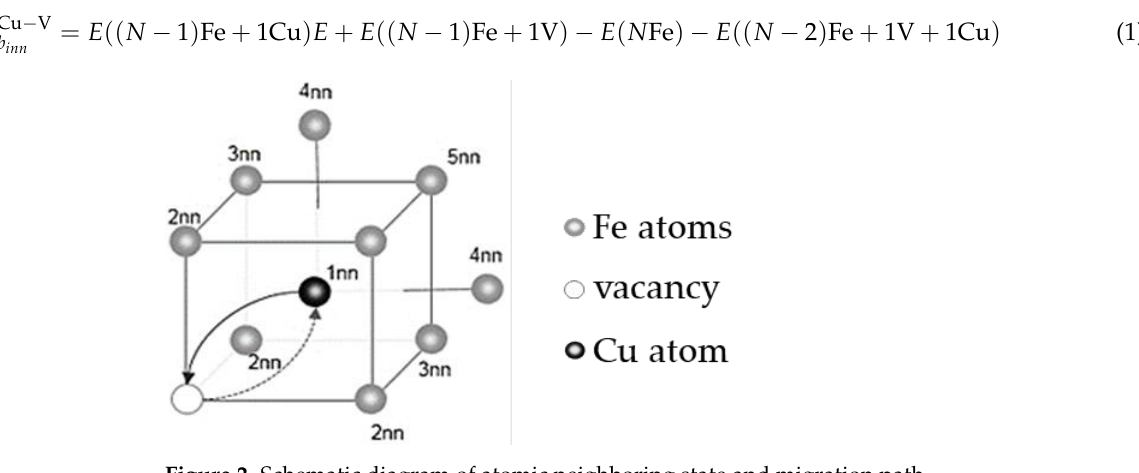
Figure 2. Schematic diagram of atomic neighboring state and migration path. The diffusion coefficient of Cu atoms in the system during the aging process of the Fe-3.5Cu-0V, Fe-3.5Cu-0.1V and Fe-3.5Cu-0.2V alloys was calculated to further explain